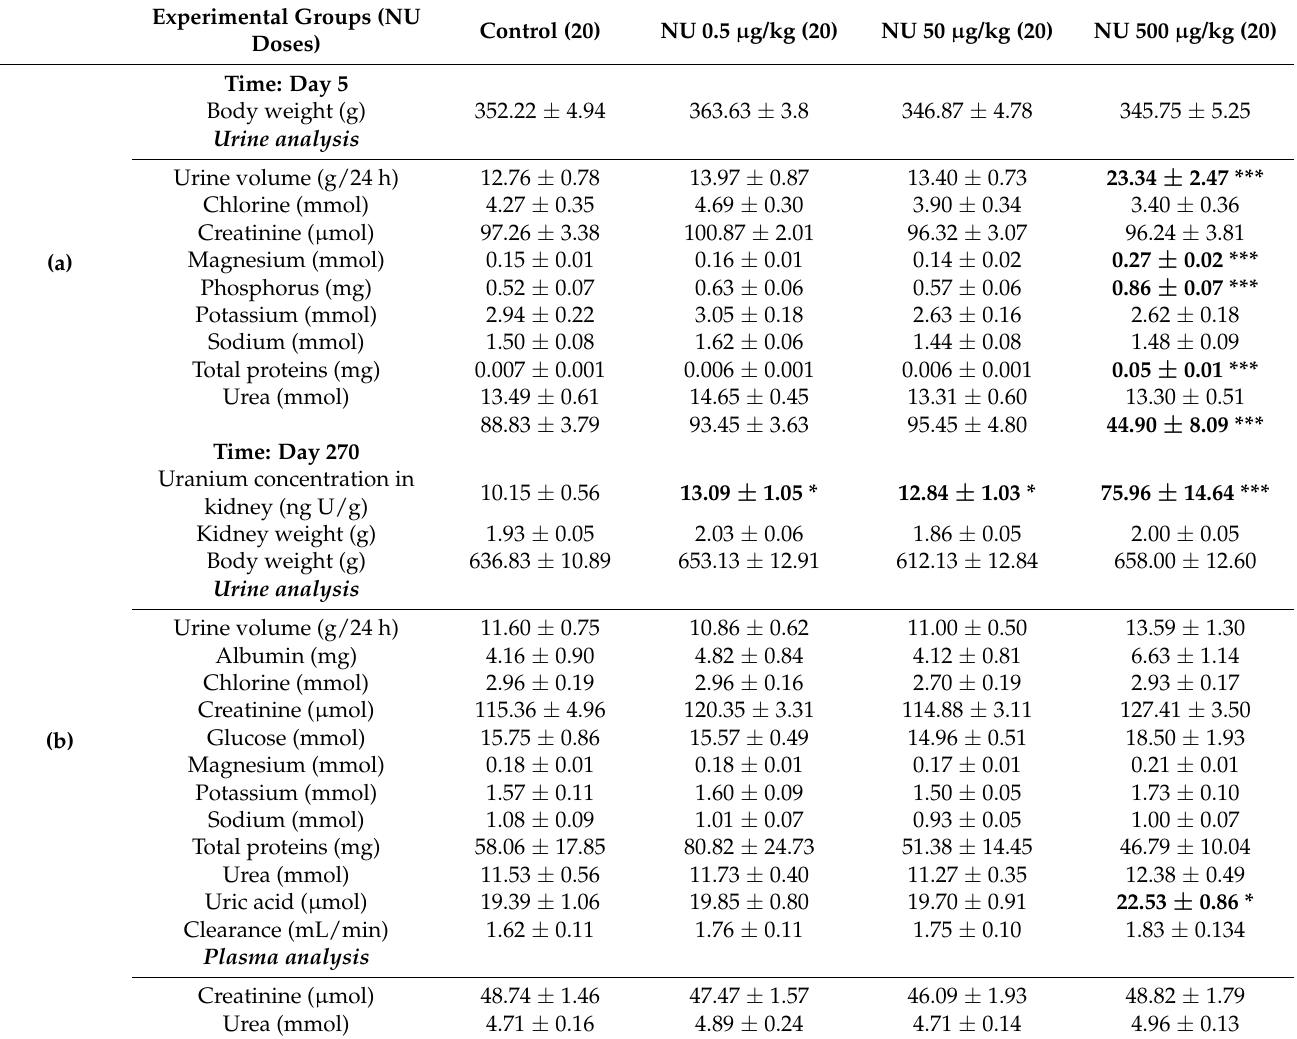
Table 1. Clinical parameters measured in urine and plasma samples on day 5 (a) and day 270 (b) and NU concentration in kidneys measured on day 270 after exposure. The number of rats for each measurement is indicated in parentheses. Results are significantly different for: * p ≤ 0.05; *** p ≤